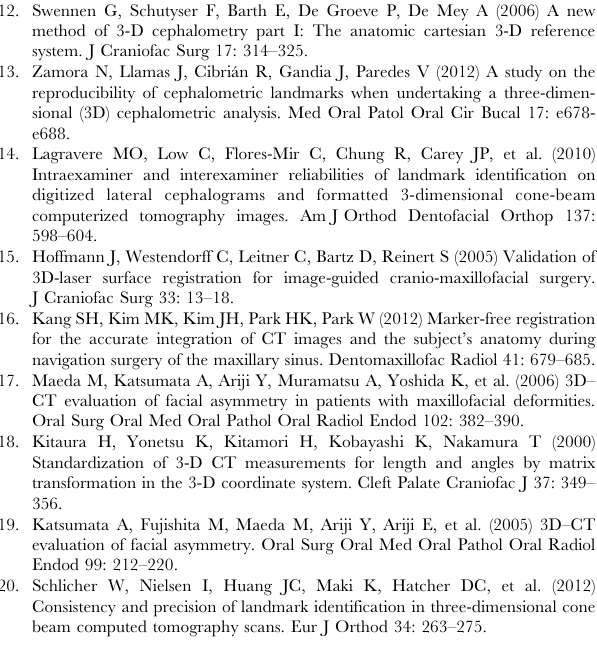
(Sample Number 18). Table S19 Coordinates before and after reorientation (Sample Number 19). Table S20 Coordinates before and after reorientation (Sample Number